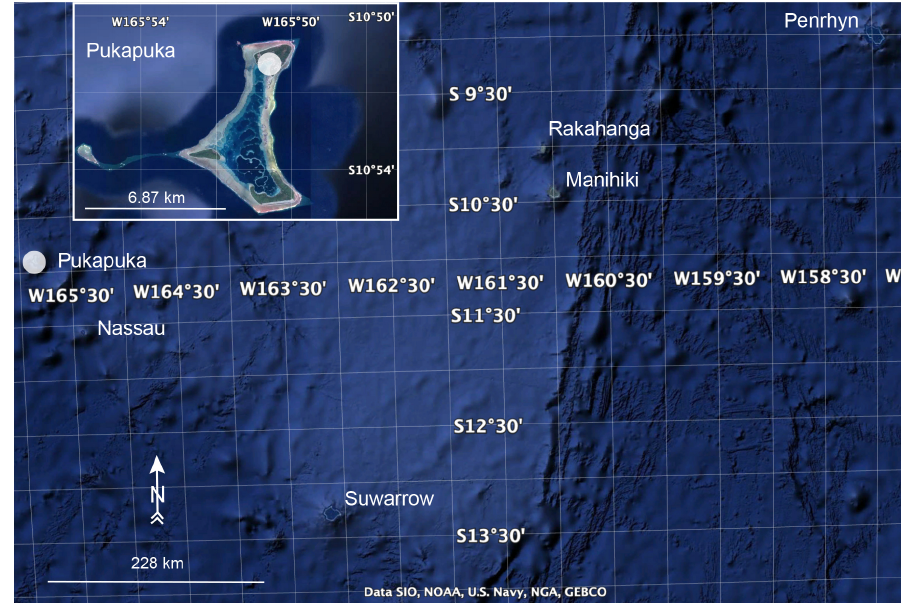
Figure 3. Map showing the northern Cook Islands. Study site on Pukapuka is indicated by a white circle. © Google Earth 2020.